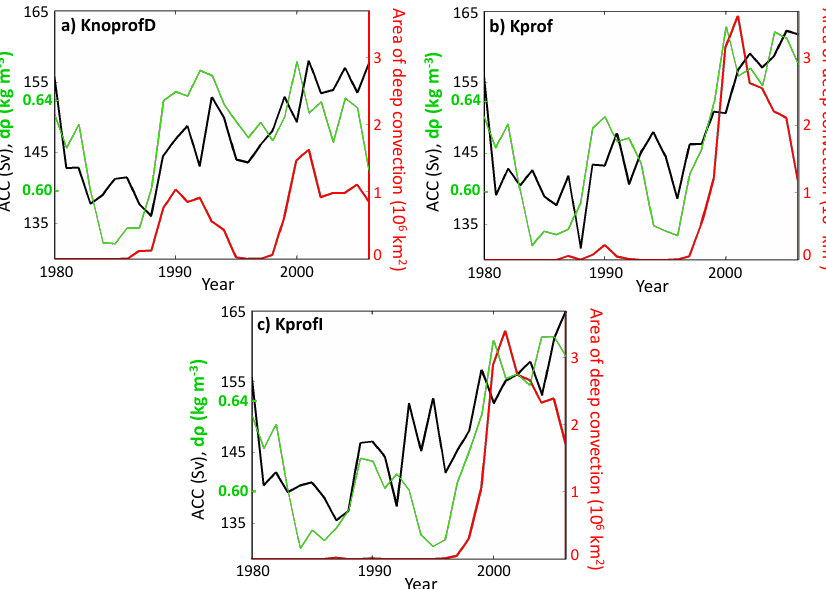
Figure 6. 27-year time series of the annual maximum ACC (black), annual mean horizontal gradient in density dρ (green) and annual maximum area of deep convection in the Southern Ocean